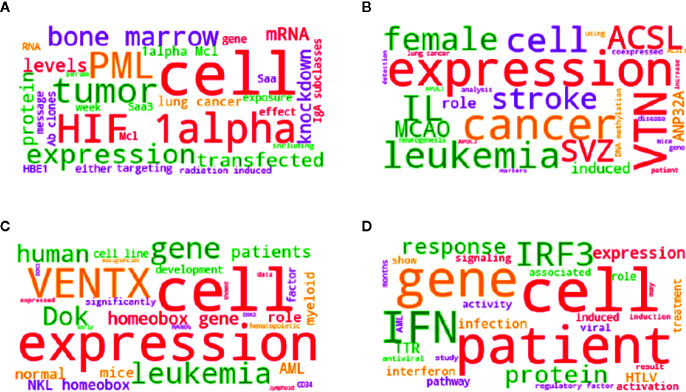
The group of proteins present in each time point and at different levels of expression, return frequencies of different terms in Pubmed search. Word cloud generated by the frequency of the terms present in the abstracts returned as a result of the search in the Pubmed. Four searches were carried out with the term leukemia and proteins in each analyzed condition [(A) - D0 down, (B) - D28 down, (C) - D0 up, and (D) - D28 up], returning the 10 most recent works. The abstracts of the works were concatenated and organized as a term corpus, analyzed by the Natural Language Toolkit package - NLTK 3.4 and WordCloud 1.6.0 for Python. The size of the word represents the frequency in the corpus.